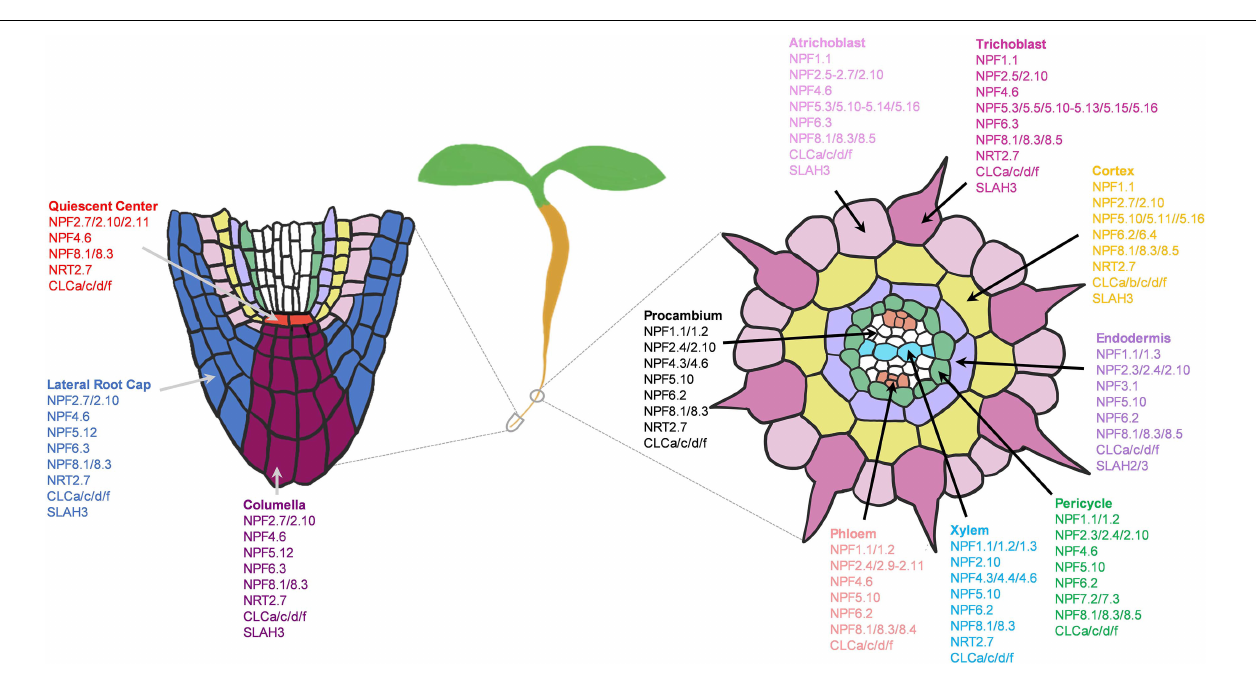
FIGURE 5 | Potential network of nitrate (NO 3 − ) channels and transporters in the root system of 5–7 days old Arabidopsis seedlings grown under the normal growth conditions. Expressed NO 3 − transporters involved in longitudinal transport (left) at the meristematic zone and radial transport (right) at the elongation/maturation zones were shown. Nitrate transporter genes not expressed under the normal growth conditions were